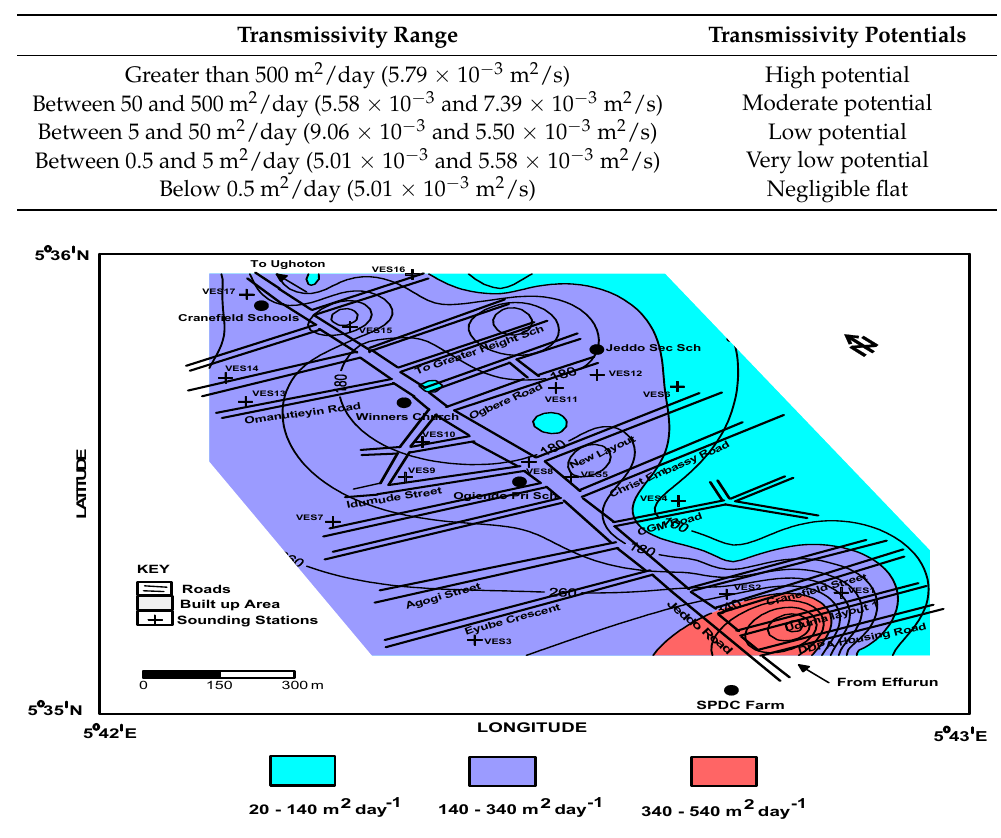
Figure 7. Map of aquifer transmissivity. Table 3. Gheorghe standard for transmissivity ( T ) [27].